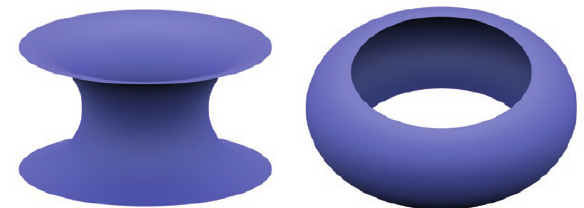
Figure 19. Decomposition of a torus into (left ) a hyperbolic surface (K<0) and (right) an elliptic surface (K>0). On average, the torus is fl at, as the hyperbolic and elliptic fractions have equal and opposite integral curvatures, for any torus, regardless of its particular geometry.